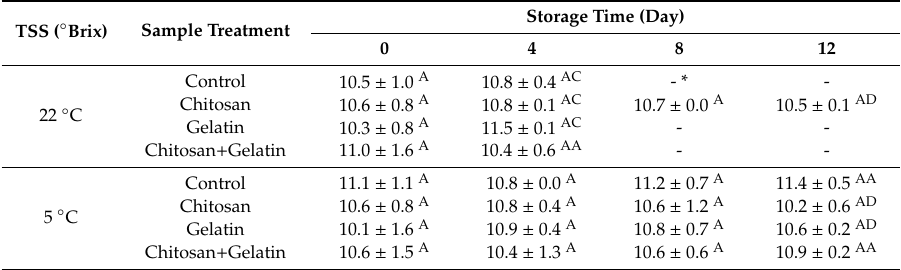
Table 4. Total soluble solids (TSS) changes of cut apple cubes coated with di ff erent coatings and stored at 5 ◦ C and 22 ◦ C for 12